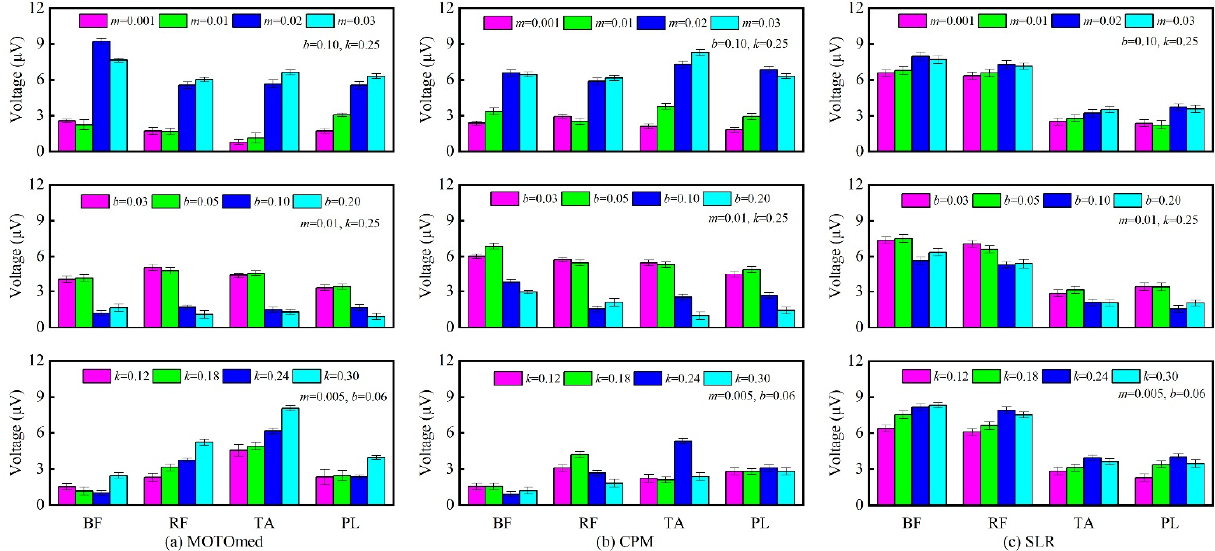
Figure 14. Maximum RMS value of sEMG signal in different training modes ( a ) MOTOmed mode; ( b ) CPM mode; ( c ) SLR mode ( m : N·s 2 /mm; b : N·s/mm; k : N/mm).